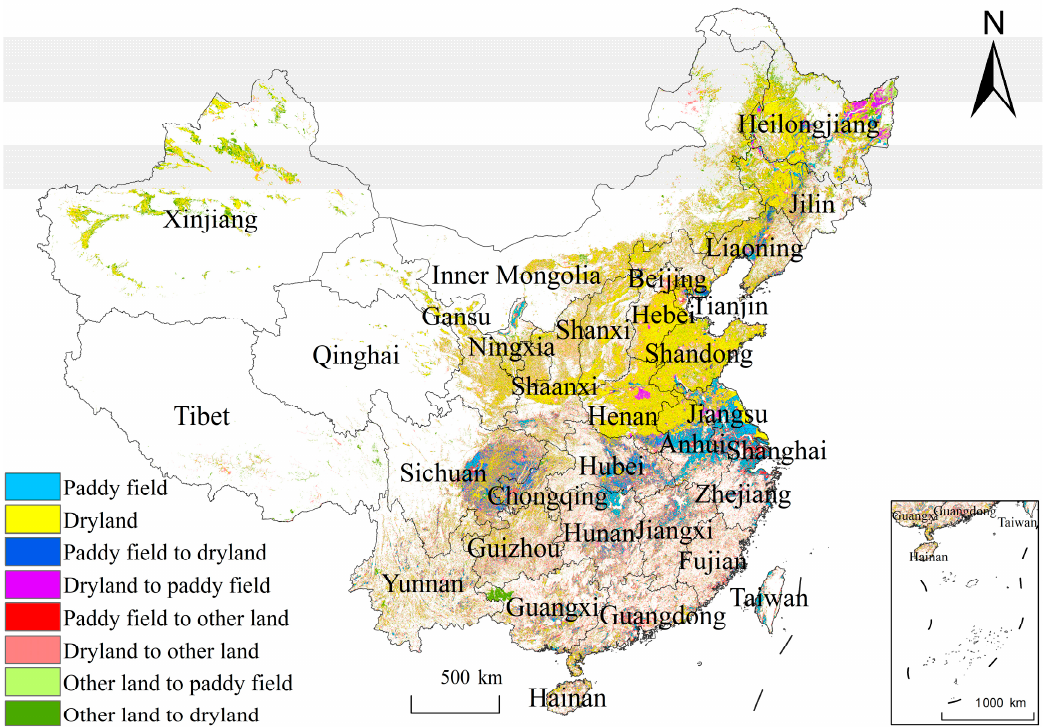
Figure 5. Land conversion between paddy field, dryland, and other land from 1990 to 2020.